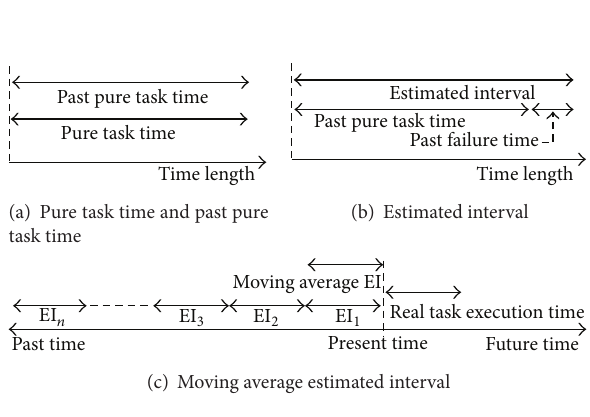
Figure 5: SLA processing.